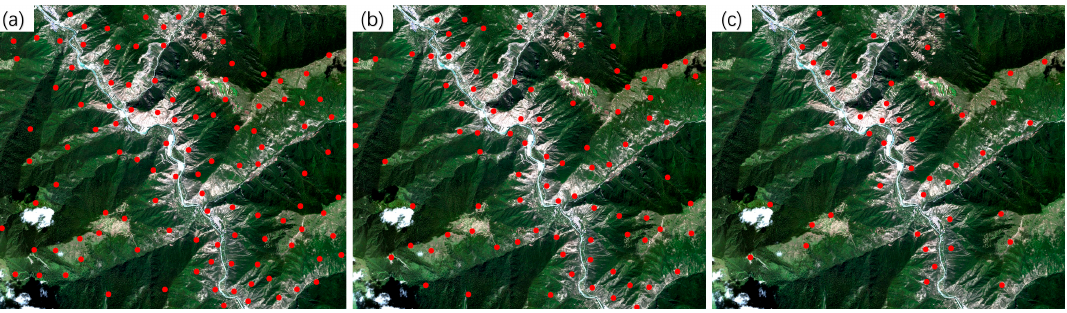
Figure 16. Registered images for the Jiuzhaigou dataset. ( a ) The original image; ( b ) the registered image of the proposed method; ( c ) the registered image of the Patch-SIFT method; and ( d ) the registered image of the SIFT method. The registered images of the Jiuzhaigou dataset using the cubic polynormal model are shown in Figure 16. As shown in Figure 16b, the registered image of the proposed method still had slight displacements with the original image. In contrast, the other two methods had noticeable displacements for rivers and roads (Figures 16c,d). This is also consistent with the RMSE T values provided by the three methods. Consequently, compared with the other methods, the proposed method can achieve a larger number of tie points, which are more evenly distributed. This is helpful for improving the accuracy of image registration.